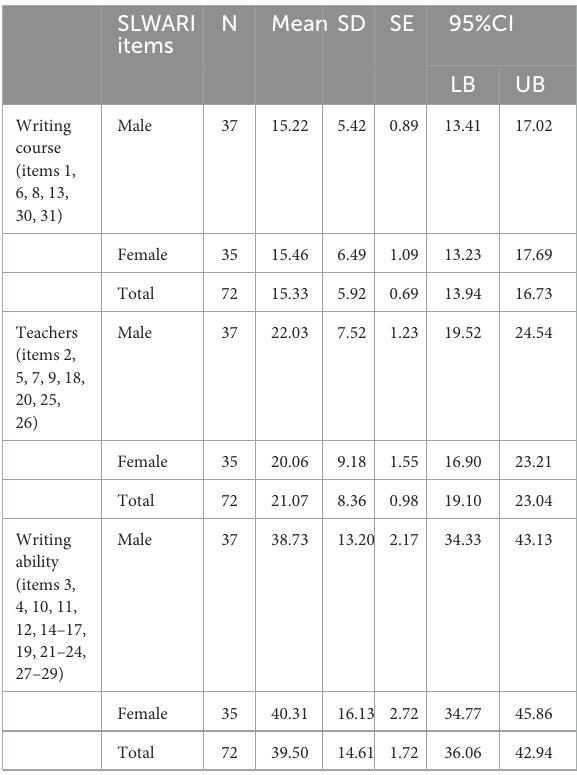
TABLE 6 Descriptive analysis based on three anxiety categories.